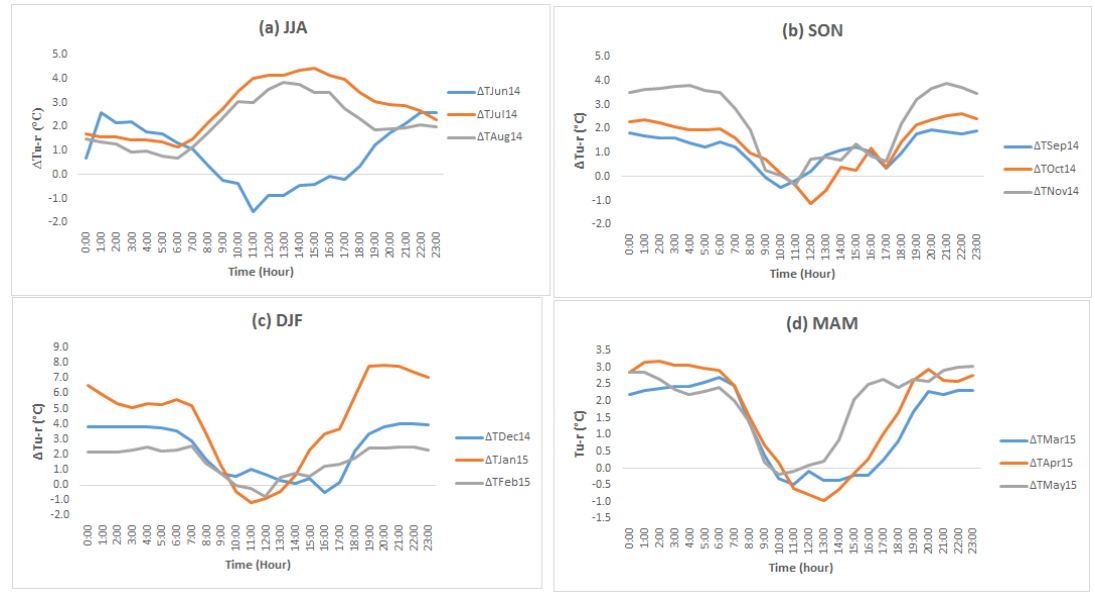
Figure 6. Seasonal variation of mean UHI in ( a ) JJA, ( b ) SON, ( c ) DJF and ( d ) MAM.